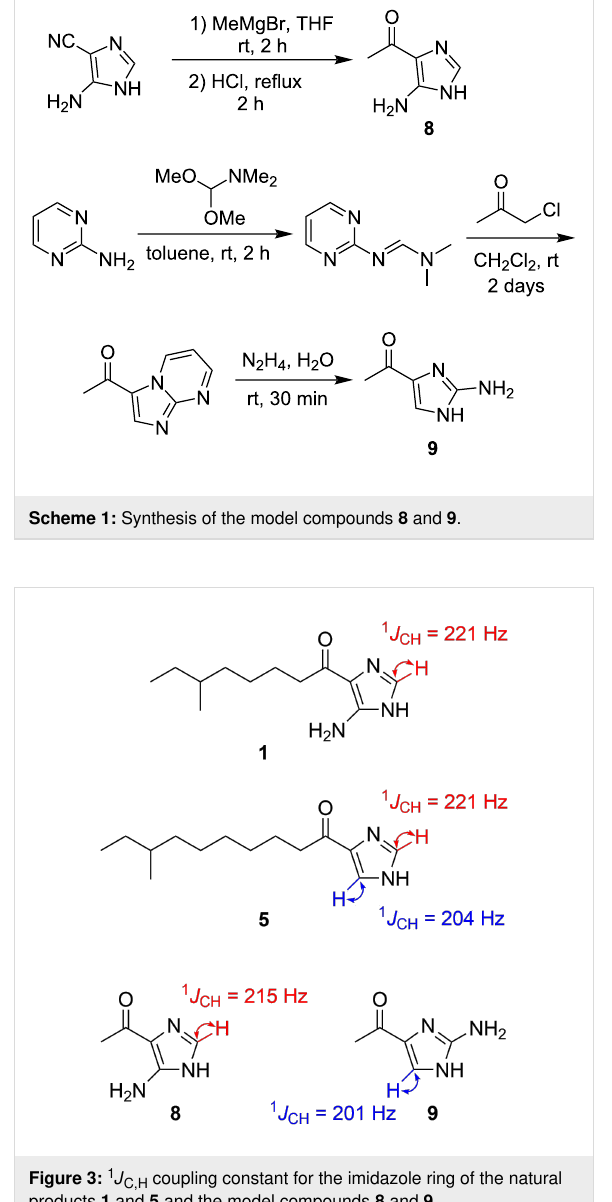
Figure 3: 1 J C,H coupling constant for the imidazole ring of the natural products 1 and 5 and the model compounds 8 and 9